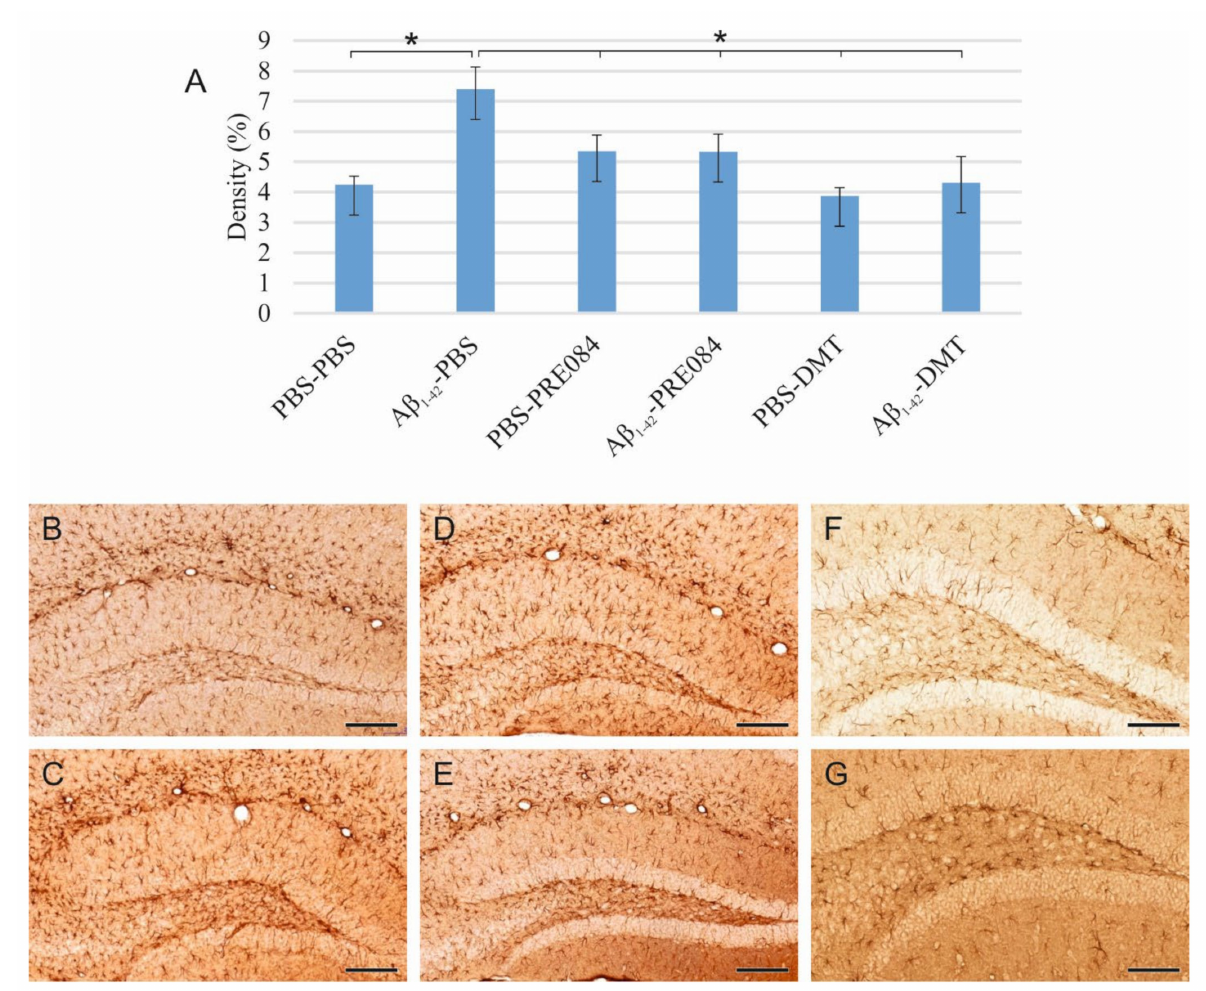
Figure 5. ( A ) Results of glial fibrillary acidic protein (GFAP) immunostaining. The densities of GFAP+ astrocytes differed among the groups (ANOVA: p ≤ 0.0001). A significantly higher GFAP+ density was detected in the A β 1–42 -PBS group compared to those treated with PBS-PBS ( p ≤ 0.0001),